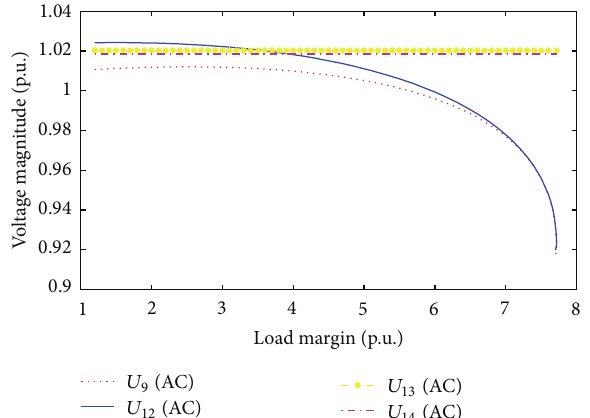
Figure 7: PV curves for modified IEEE-14 bus system in operating mode “4.” Table 4: Performance comparison of the modified IEEE-118 test system for four different operating modes.